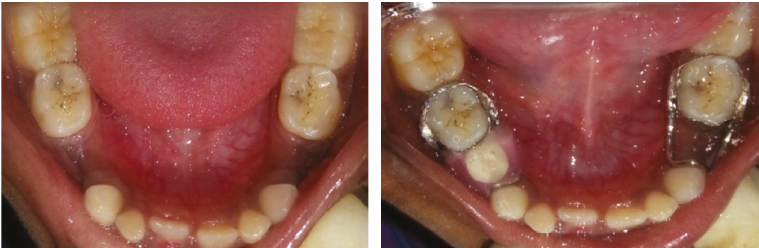
Figure 5: Preoperative and immediate postoperative views of the mandibular arch with the conventional band and loop space maintainer in the tooth 74 region and functional band and loop space maintainer in the tooth 84 region.